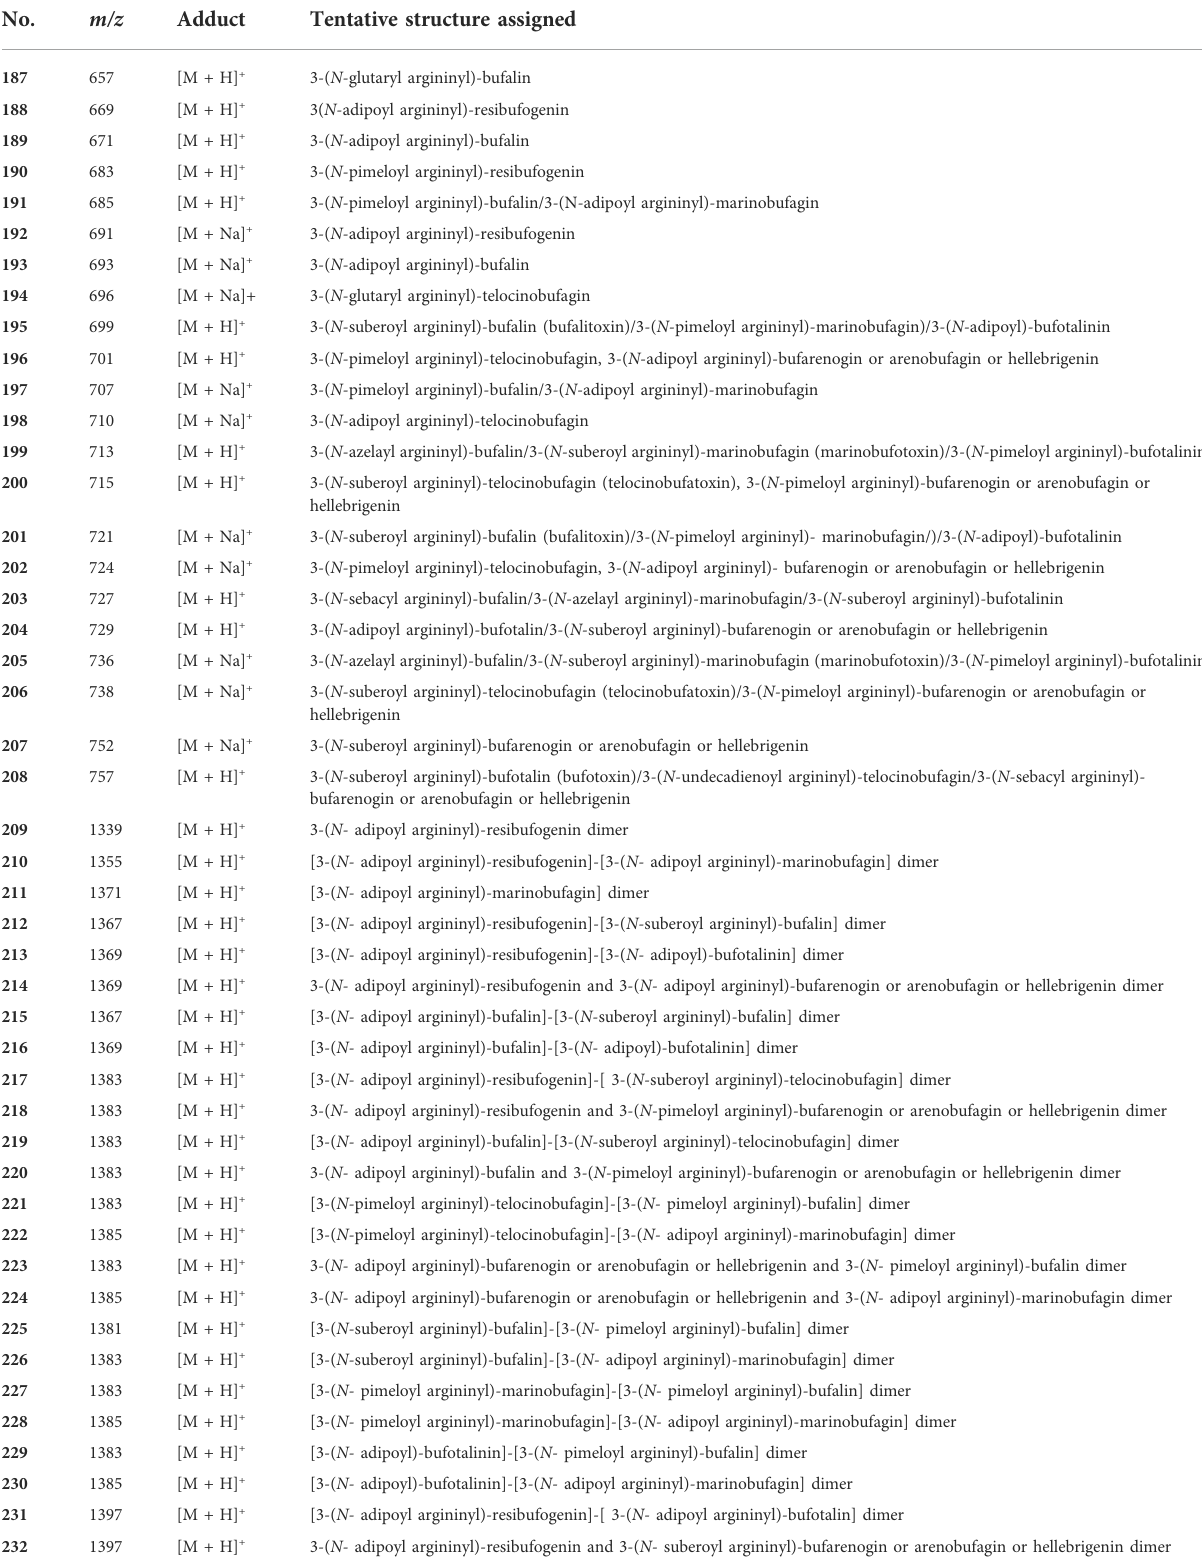
TABLE 1 Conjugated bufadienolide detected in Argentine Toad venom by MALDI-MS. No. m/z Adduct Tentative structure